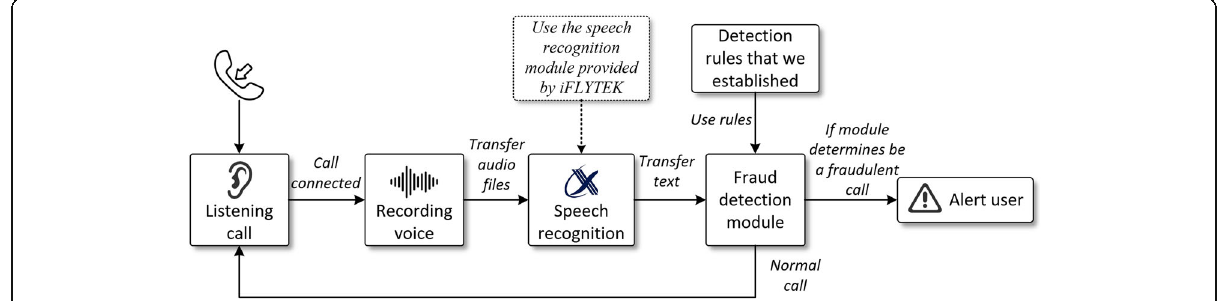
Fig. 4 Structure of telecommunication fraud alert